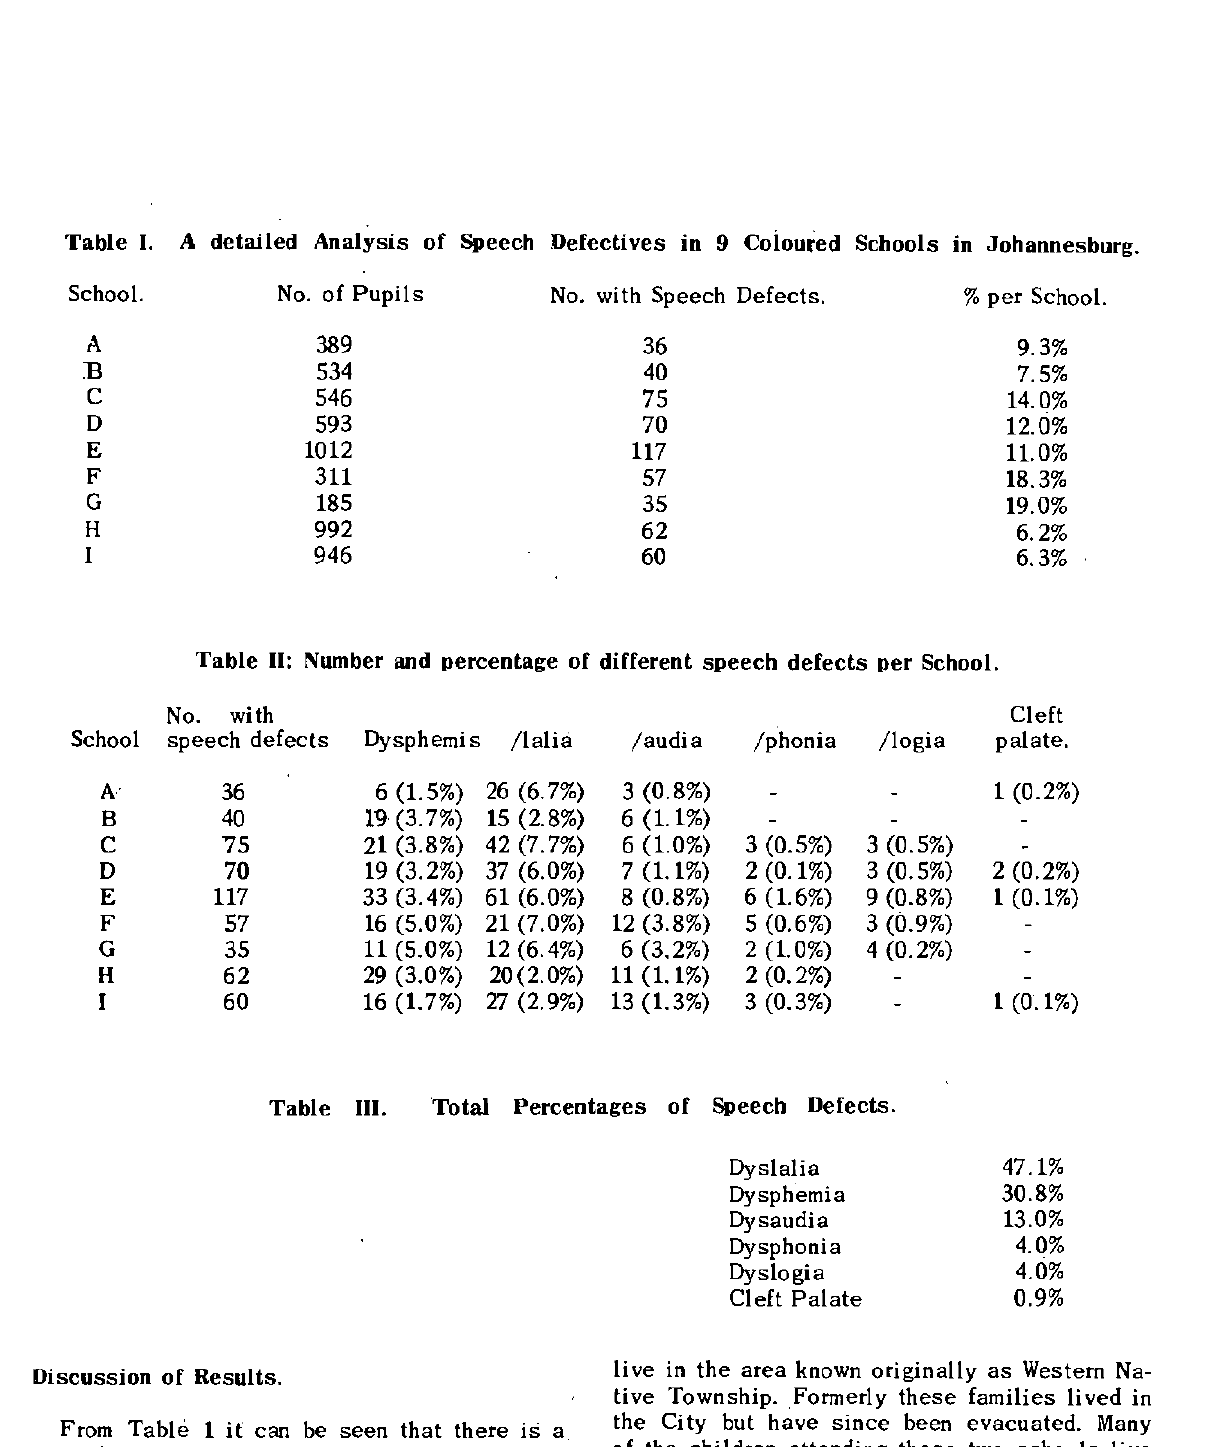
Total Percentages of Speech